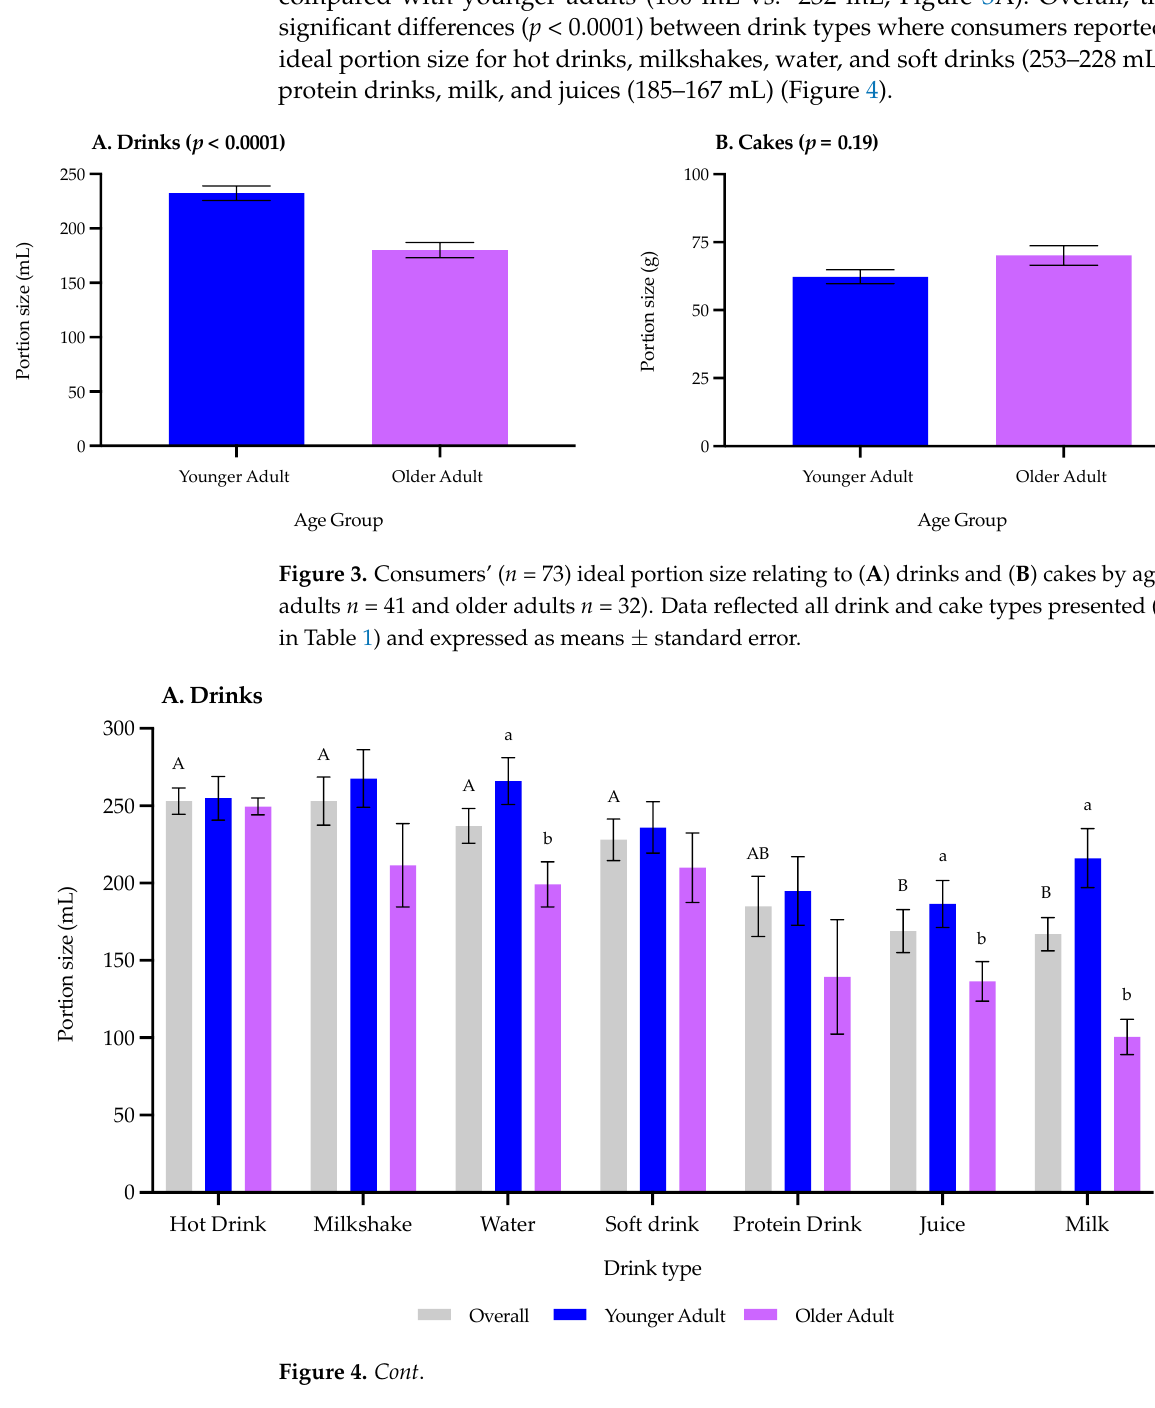
Figure 4. Consumers’ ( n = 73) ideal portion size relating to ( A ) drinks and ( B ) cakes by type and age (younger adults n = 41 and older adults n = 32). Data expressed as means ± standard error. Differing letters reflect significance in preferred portion size as follows: (i) drink and cake types (capital let- ters) from Kruskal-Wallis and (ii) younger and older adults (small letters) via Mann-Whitney. 3.3. Protein Fortification Attitudes Questionnaire Older adults consumed protein-fortified products significantly less frequently ( p < 0.0001) compared with younger adults (14% vs. 67%; Figure 5). There were significant differences ( p < 0.0001) between consumers’ factors in terms of importance when selecting protein-fortified products were observed. Consumers ranked taste (1.7 a) and flavour (2.6 a) as key attributes followed by texture (3.8 b), cost (4.0 bc), smell (4.2 bc) and appearance